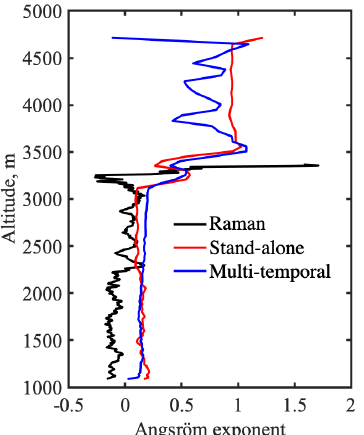
Figure 34. Vertical profile of the Ångström exponent at 355 / 532nm retrieved from LILAS observations using stand-alone (red) and multi-temporal approaches (blue) performed on 16 April 2015 in comparison with estimation from 355 / 532nm inelastic backscatter measurements (black).